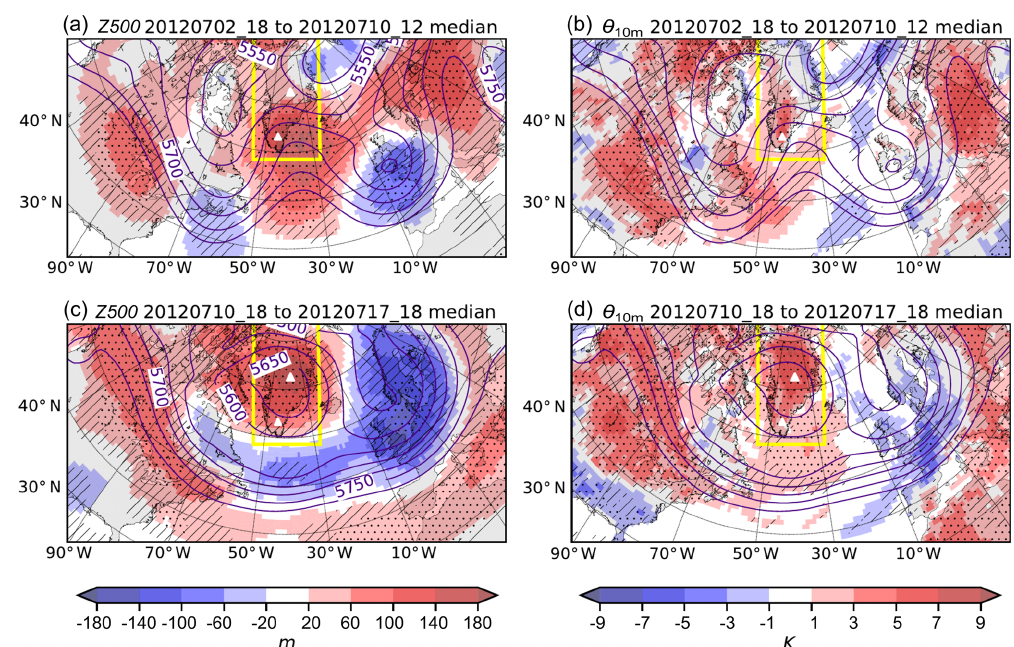
Figure 1. The median fields of 500hPa geopotential height ( Z 500; contours) for the two periods during EV69 from (a, b) 18:00UTC on 2 July to 12:00UTC on 10 July (8d) and (c, d) 18:00UTC on 10 July to 18:00UTC on 17 July (7.25d). Median anomalies of the synoptic fields in the respective periods are shown in colors: (a, c) Z 500 and (b, d) near-surface potential temperature ( θ 10m ). Hatching (stippling) indicates an anomaly outside the 25–75 (10–90) percentile range of equally long periods in JJA 1979–2017. The yellow box indicates the location of the